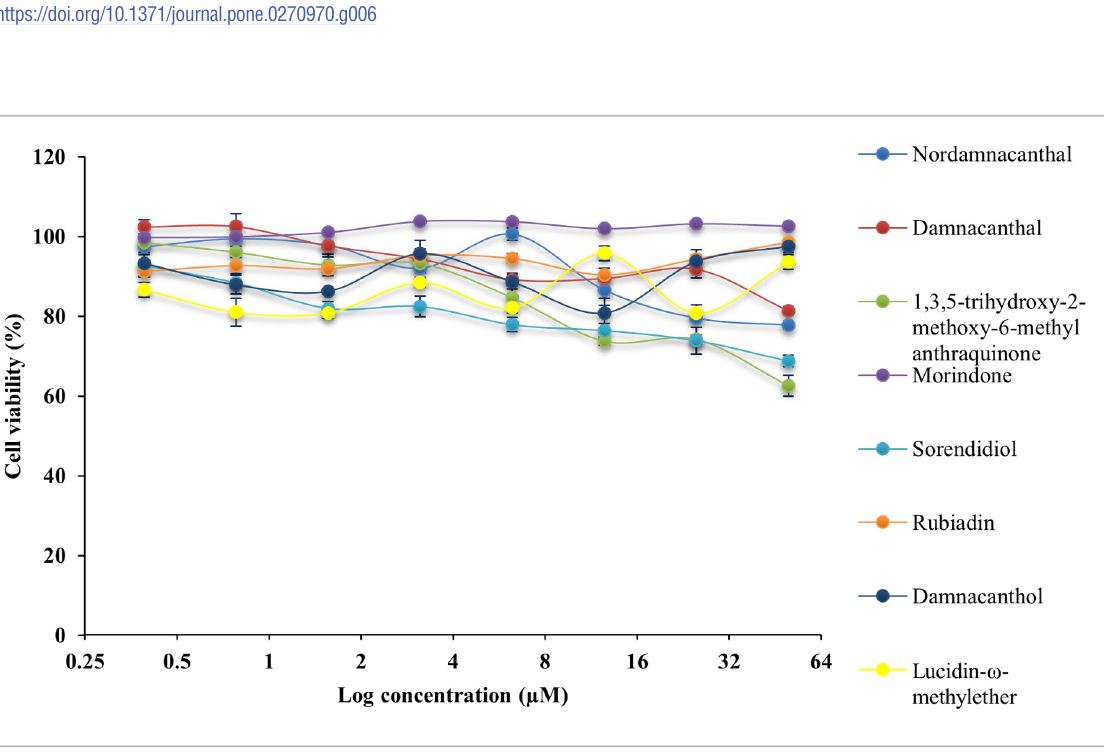
PLOS ONE | https://doi.org/10.1371/journal.pone.0270970 July 12,